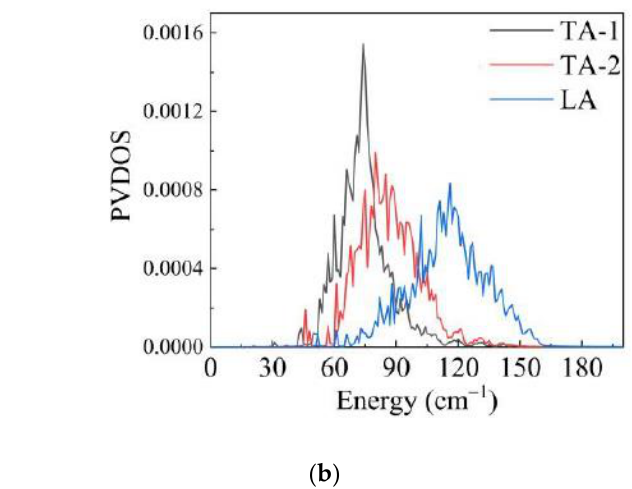
Figure 6. ( a ) Red line is the VDOS of α-Cristobalite with the quartic anharmonic interaction. The black line is the VDOS with the cubic and quartic anharmonic interactions. ( b ) Partial vibration density of states (PVDOS) of α-Cristobalite with the cubic and quartic anharmonic interactions.